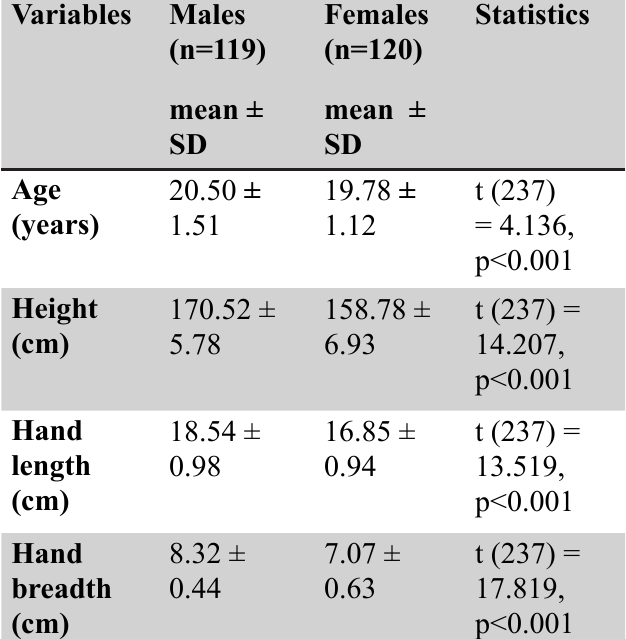
Table 1: Comparison of the findings of male and female